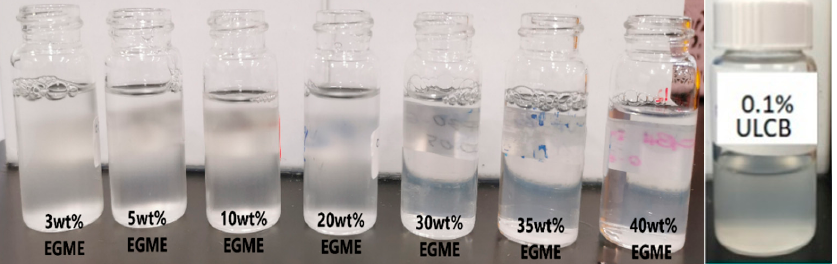
Figure 3. Solubility of surfactant mixture with different co-solvent concentration diluted to 0.1 wt.% in seawater with ethylene glycol mono butyl ether (EGME) at 3, 5, 10, 20, 30, 35, and 40 wt.% compared to 0.1 wt.% as-synthesized surfactant in seawater (ULCB).